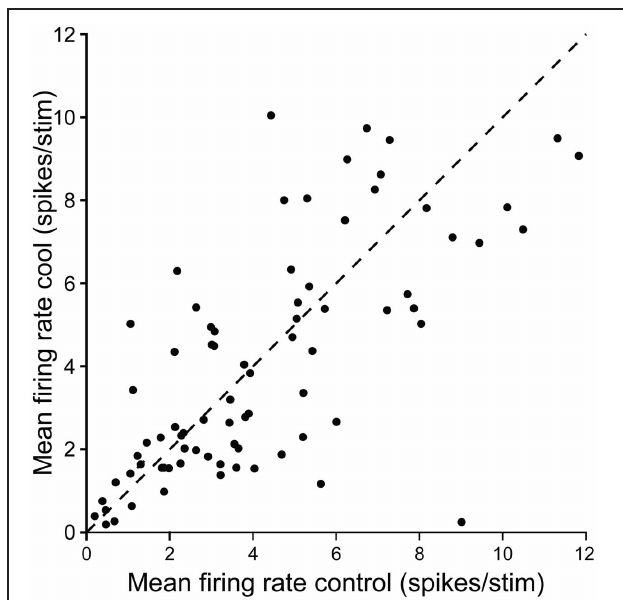
FIGURE 11 | Scatter plot showing control firing rate versus firing rate during cooling for single neurons recorded in the IC while cooling the contralateral IC. Dashed line shows the line of identity.